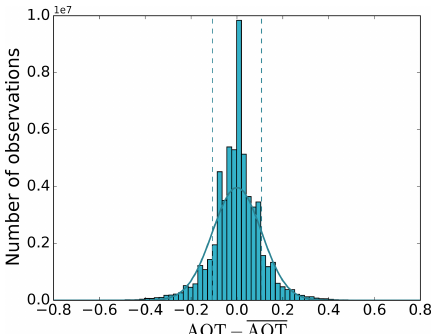
Figure 14. Histogram of the difference between AOT retrieved at t = 0 and the running mean calculated between t − 15 and t + 15min from 1 to 12 September 2017. Observations within the glory region have been removed. Dashed lines represent the mean ± the standard